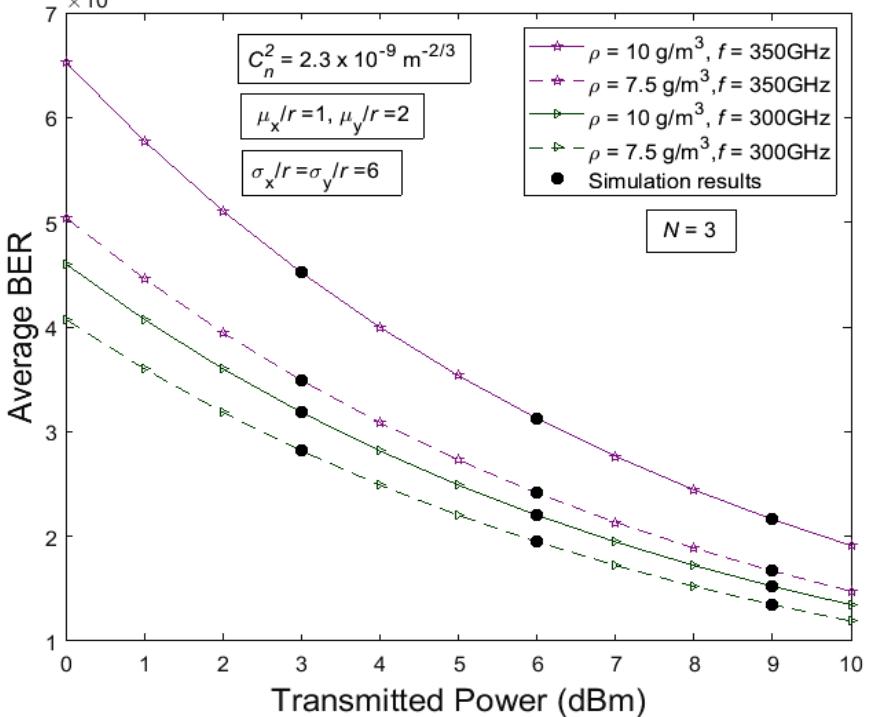
Figure 4. ABER vs. transmitted power for a triple-hop THz link configuration under strong turbu- lence, moderate-to-high water vapor concentrations, different operational frequencies and strong NZB pointing errors.